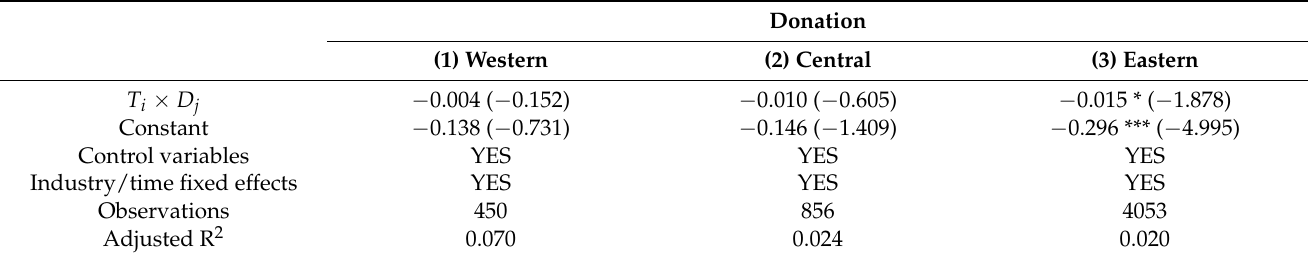
Table 9. Results of the effect of regional differences.